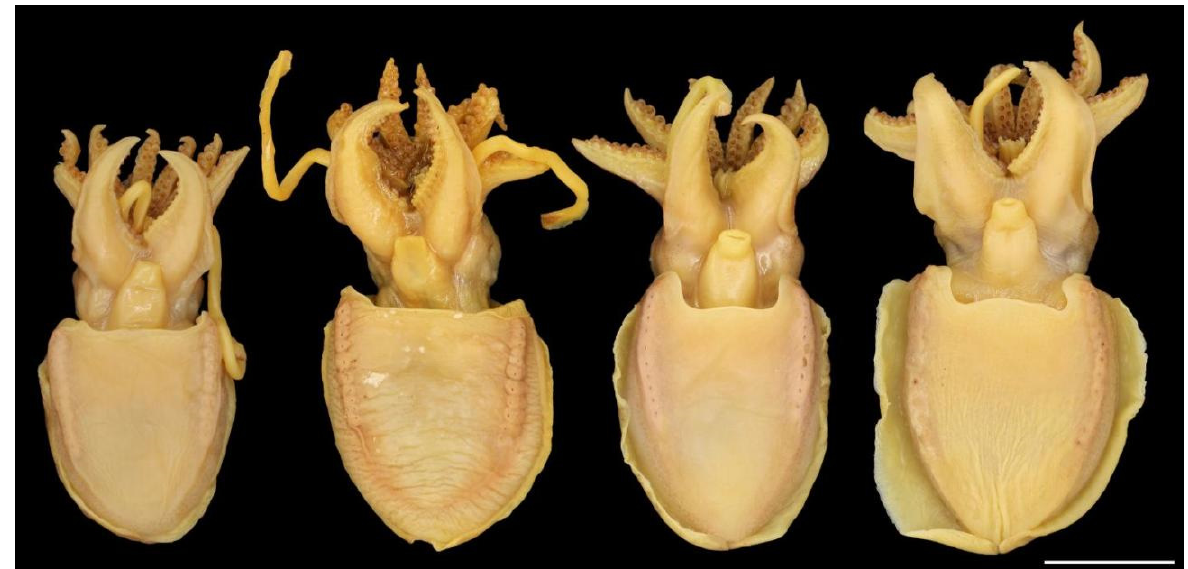
Figure 5. Variation in the shape of the dorsal mantle margin in Sepia typica : from left to right: SAIAB 211543, male ML 18 mm; SAIAB 211610, male ML 20 mm; SAIAB 211550, female ML 17 mm; SAIAB 211529, male ML 23 mm. Scale bar 10 mm.